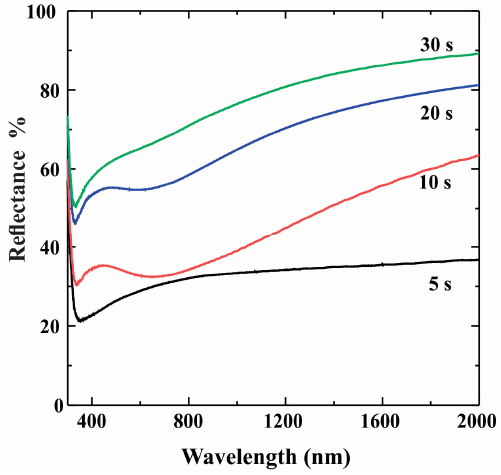
Figure 7. Reflectance spectra of Ag–Ta thin films.